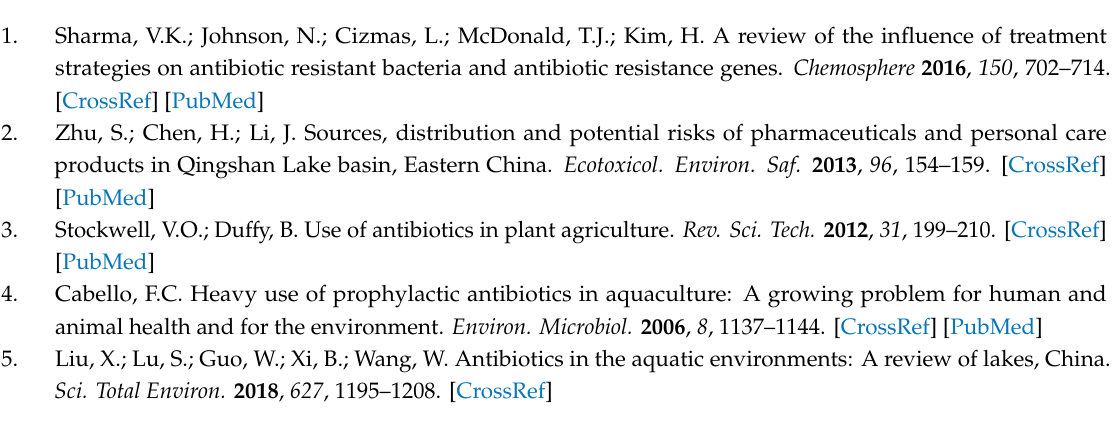
Table S1: The information of antibiotics used in this study, Table S2: The dominant phyla (average abundance > 1.0%) in each treatment, Table S3: The dominant genera (average abundance > 1.0%) in each treatment, Table S4: SIMPER analysis of the bacterial community in antibiotic-treated group and Control group at the OTU level, Table S5: SIMPER analysis of the bacterial community in groups of di ff erent enrichment time at the OTU level, Figure S1: The number of shared and unique OTUs in the samples of the same group. (a) zinc bacitracin-treated group; (b) ciprofloxacin-treated group; (c) ampicillin sodium-treated group; (d) chloramphenicol-treated group; (e) tylosin-treated group; (f) tetracycline-treated group, Figure S2: Composition of microbial community at the class level, Figure S3: Hierarchical clustering tree at OTU level, Figure S4: NMDS (Abund–Jaccard distance) plot based on OTUs abundance showing the microbial composition variations among di ff erent samples, Figure S5: Comparison of control group and di ff erent antibiotic-treated groups at phylum level, Figure S6: Comparison of control group and di ff erent antibiotic-treated groups at genus level, Figure S7: Comparison of samples of di ff erent enrichment time at phylum level, Figure S8: Comparison of samples of di ff erent enrichment time at genus